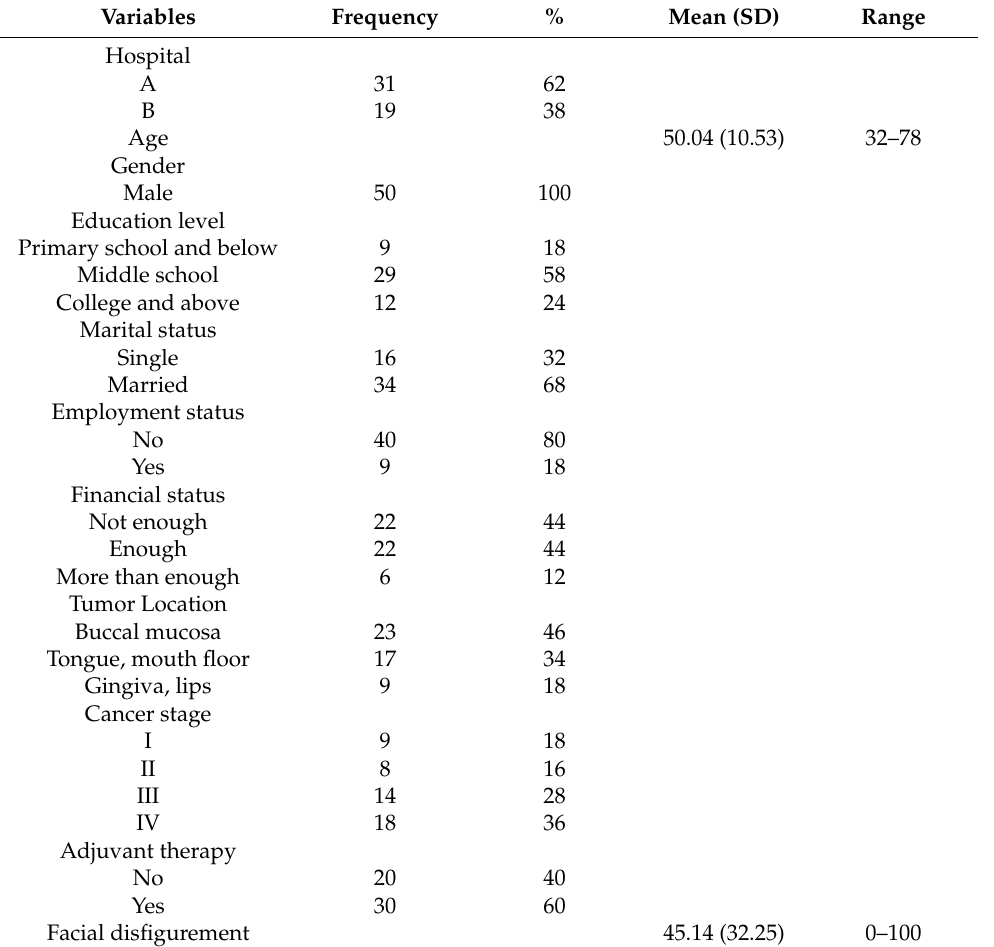
Table 1. Demographics, disease characteristics, and perceived facial disfigurement ( N =